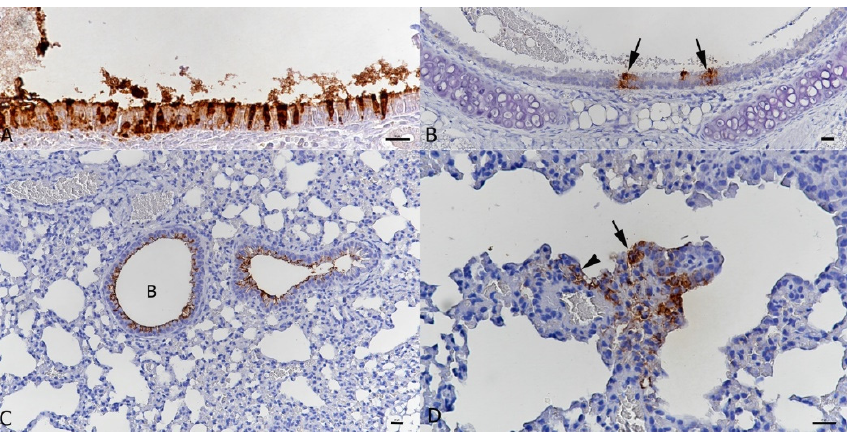
Figure 5. BALB-C mouse, male. Two days post intranasal infection with 6 × 10 3 PFU of beta variant SARS-CoV-2. ( A ). Nose with focal extensive viral antigen expression in ciliated epithelial cells. Bar = 20 µ m. ( B ). Trachea with small patches of positive epithelial cells (arrows). Bar = 20 µ m. ( C ). Lung with viral antigen deposition along the luminal surface of the bronchiolar epithelial cells. B: bronchiole. Bar = 20 µ m. ( D ). Lung. Small focal area with viral antigen expression in type I (arrowhead) and type II (arrow) alveolar epithelial cells. Bar = 10 µ m. Immunohistochemistry, haematoxylin